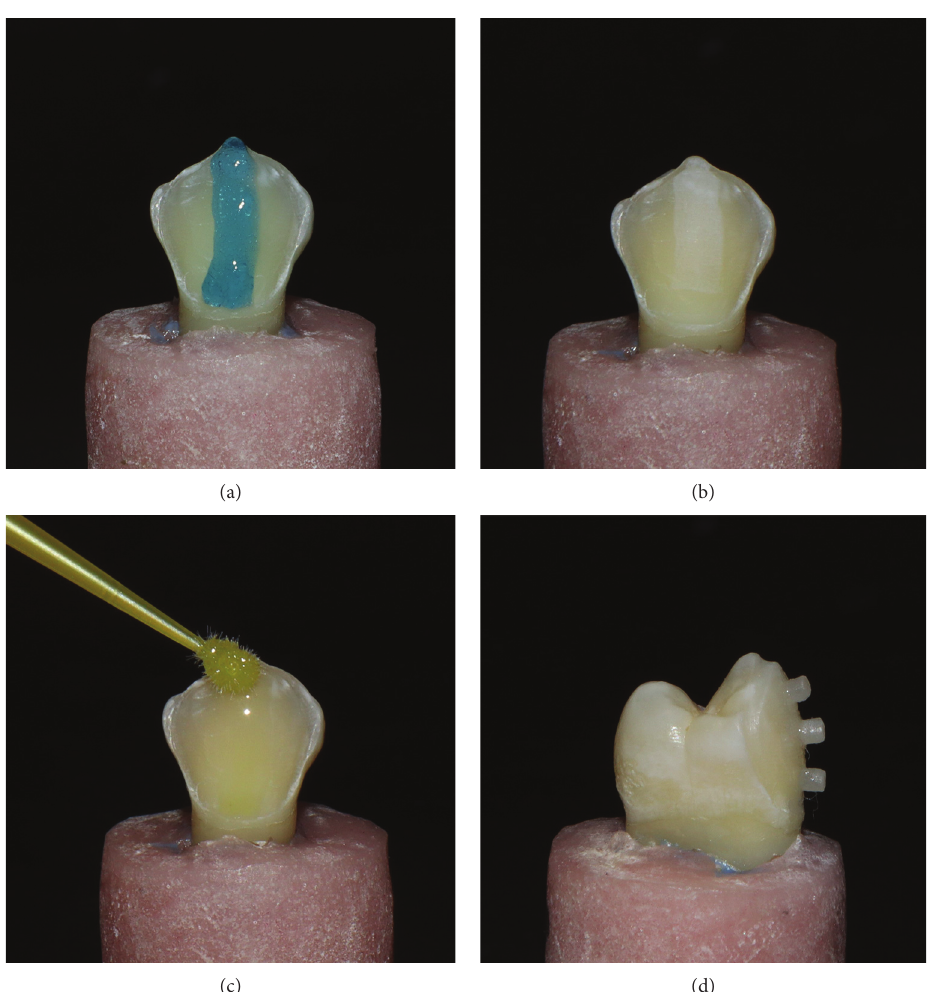
Figure 2: (a) Strip of etching gel at center of buccal surface to prevent the waste of material. (b) Chalky-white surface after rinsing of the etching gel. (c) Application of adhesive. (d) Cementation of microdiscs, proximal